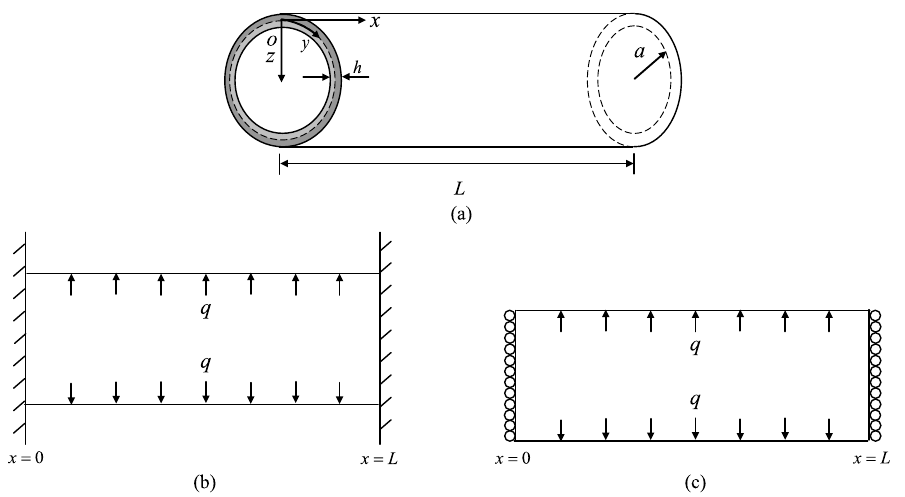
Fig. 1. (a) The geometry of a FGPM cylindrical shell; (b) Fixed of both ends; (c) Simply supported of both